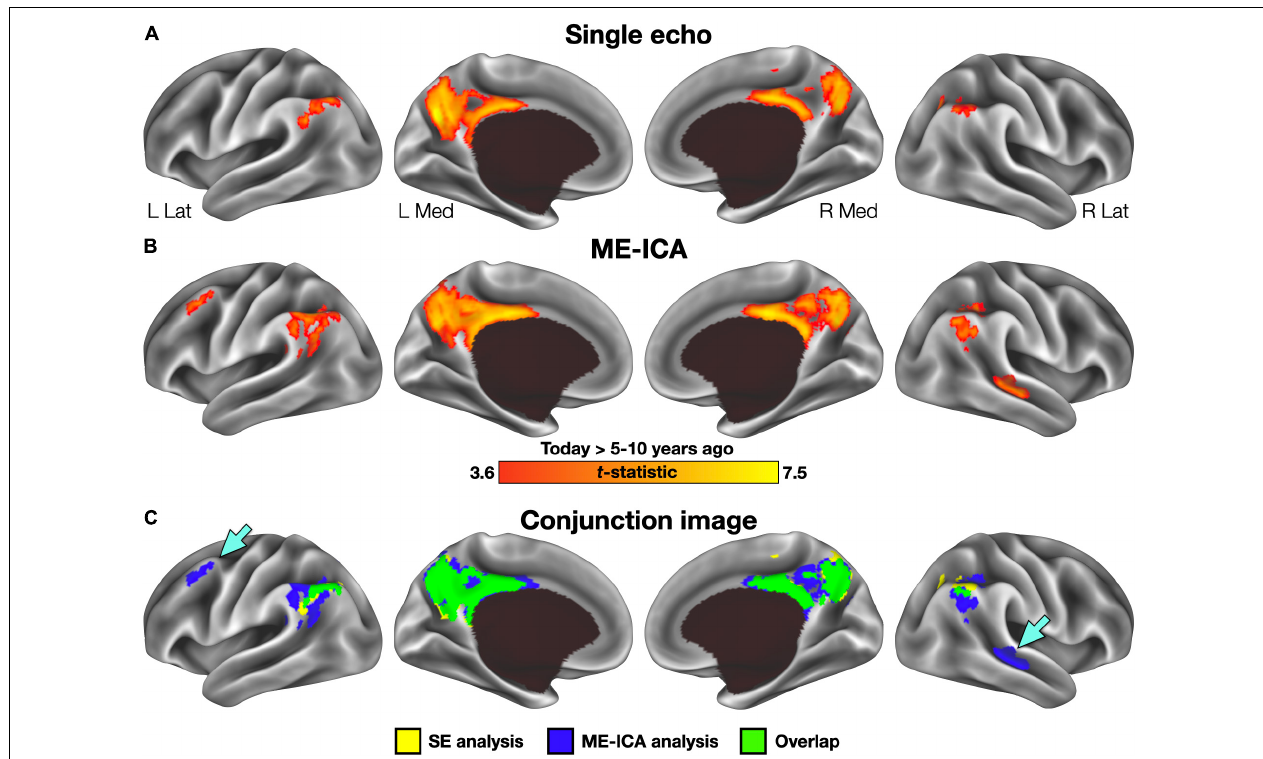
FIGURE 3 | Voxelwise results for each preprocessing stream. (A) Regions exhibiting greater activity in the Today than 5–10 year ago condition following single-echo (SE) preprocessing included a large cluster in the posterior midline and inferior parietal lobule bilaterally. No clusters were identified with significantly greater activity for the 5–10 year ago condition. (B) Regions identified in the same analysis using multi-echo ICA (ME-ICA) data were larger and included several additional clusters in the right temporal and left frontal cortex. (C) A binarized conjunction image allows for easy visualization of the improved sensitivity offered by ME-ICA processing. Inset arrows identify significant clusters absent from the SE